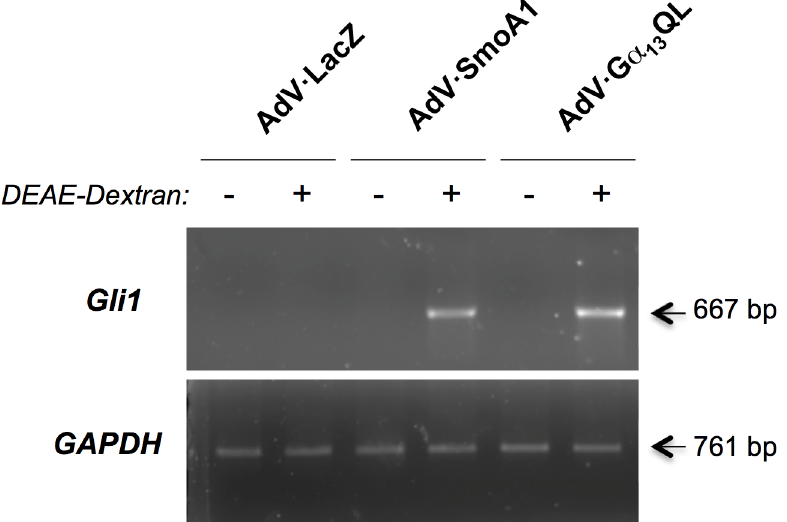
Fig 2. Induction of Gli1 by SmoA1 and G α 13 QL. C3H10T1/2 cells were transduced with recombinant adenoviruses encoding LacZ, SmoA1, or G α 13 QL (MOI = 10) in the presence or absence of DEAE-Dextran (10 μ g/ml) as noted. At 2 days following transduction, RNA was extracted for PCR with primers specific for Gli1 and, as a control for loading, GAPDH. Arrows denote anticipated sizes of the products. Shown is one experiment, which is representative of three